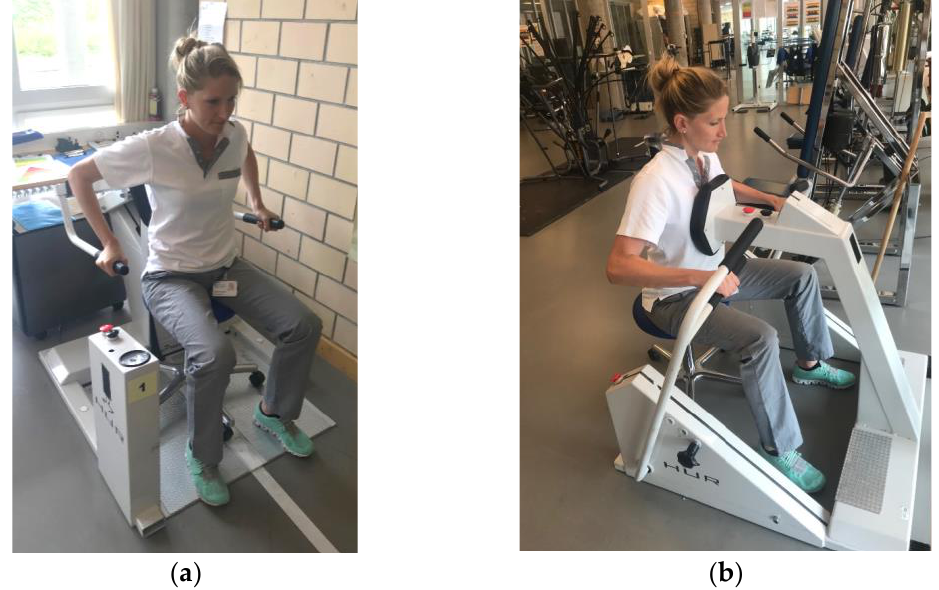
Figure 1. Triceps press ( a ) and horizontal rowing pull ( b ) machine used for training.